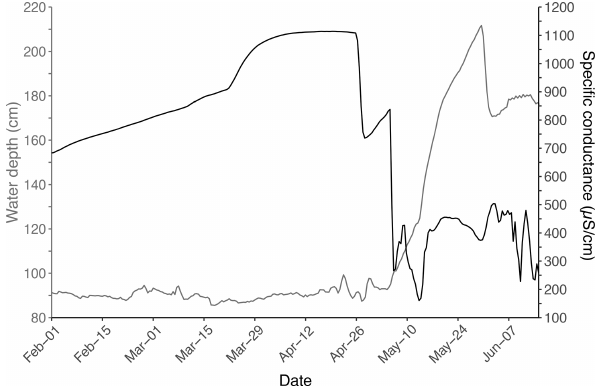
Figure 3. Measurements of water depth (gray line) and specific conductance (black line) at Highway 130 Lake in